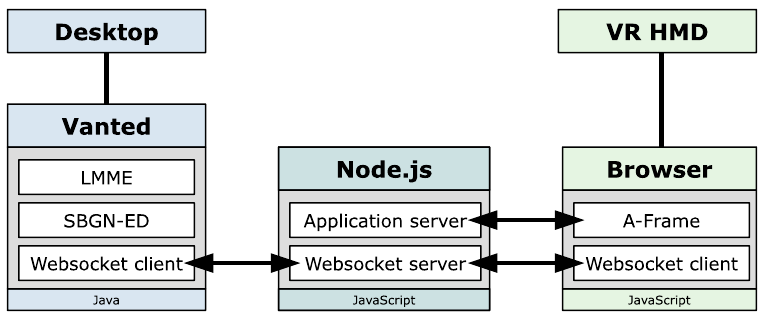
Figure2: Aschematicoverviewofthe envisioned technical realisation of the proposed concept for a hybrid user